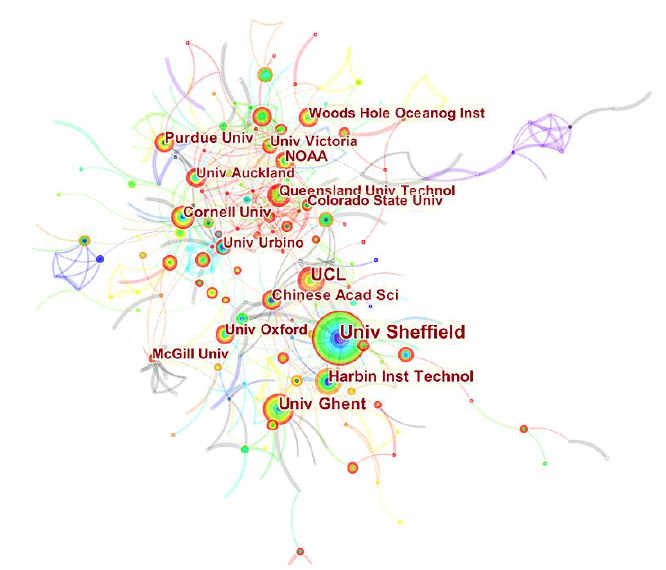
Figure 2. A network map showing institutional collaborations in soundscape research.